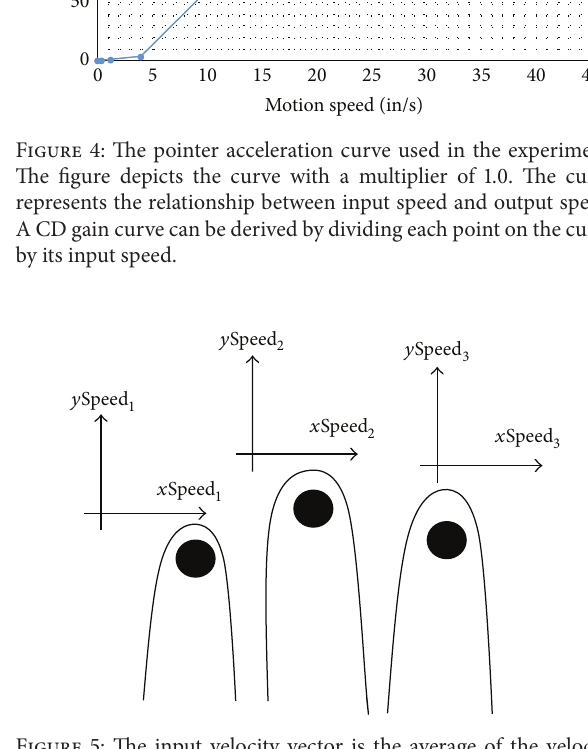
Figure 5: The input velocity vector is the average of the velocity vectors of all fingers that are in contact with the